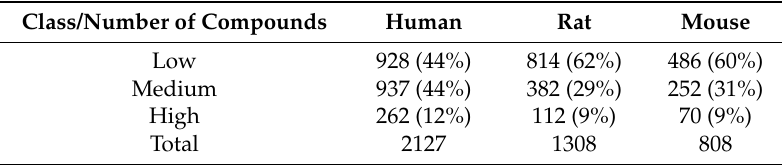
Table 3. Statistics of number of compounds belonging to each class.